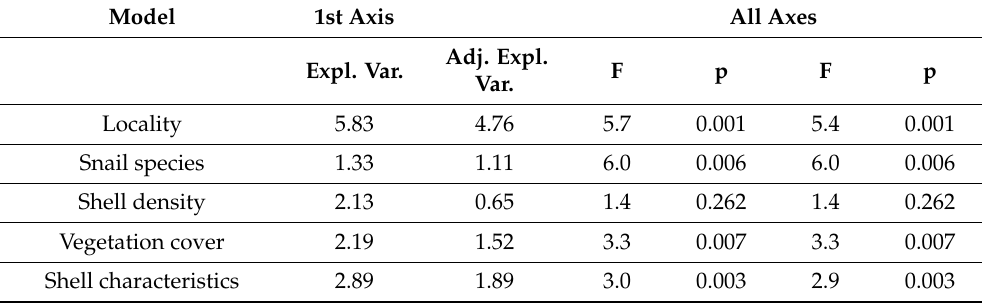
Table 4. Summary of multivariate tests analyzing differences among spider species occupying shells. Model 1st Axis Expl. Var. Locality